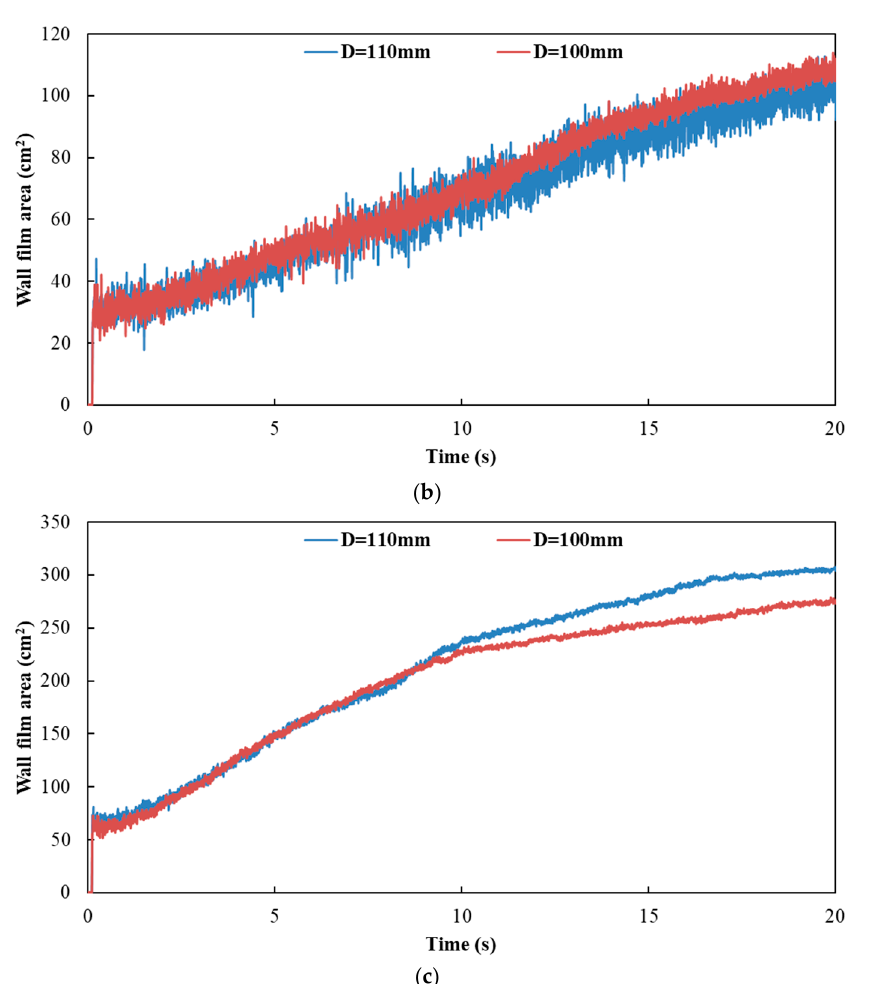
Figure 18. Influence of different exhaust pipe diameters on wall film area. ( a ) Case 1; ( b ) Case 2; ( c ) Case 3.